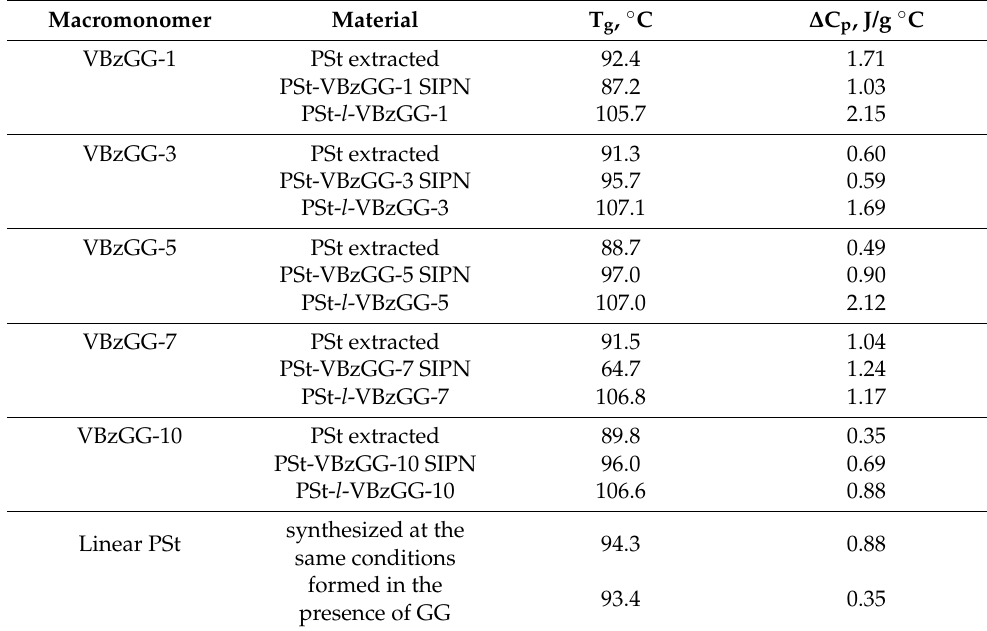
Table 2. Glass transition temperature (T g ) and heat capacity jump ( ∆ C p ). VBzGG-m amount: 1